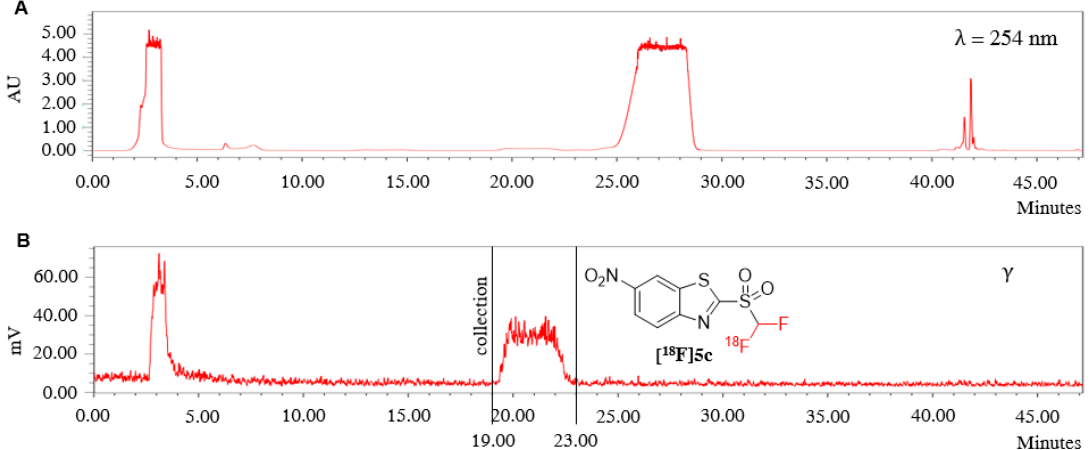
Figure 5. ( A ) UV-HPLC purification profile of the crude [ 18 F]5c . ( B ) Radio-HPLC purification profile of the crude [ 18 F]5c . Note: the appearance of broad flat-topped peaks in UV-HPLC chromatogram is derived from a saturation of the UV detector by the injecting crude product [ 18 F]5c .